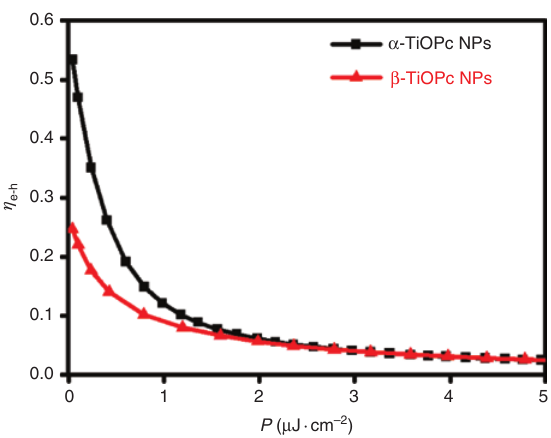
Figure 6: The photogeneration quantum efficiency as a function of exposure